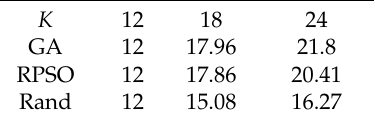
Figure 6. System capacity for various population sizes with K = 18. Table 5. System capacity comparisons of RPSO, GA and Rand methods with M = 100 and G = 200. K